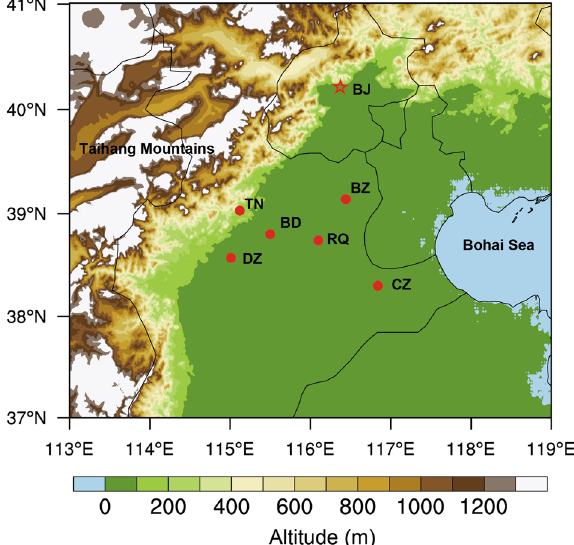
Fig. 1 Geographical locations of the six observation stations. TN, BD, RQ, CZ, BZ, and DZ represent Tuonan, Baoding, Renqiu, Cangzhou, Bazhou, and Dingzhou stations, respectively. The red star is the location of the capital city, Beijing (BJ).